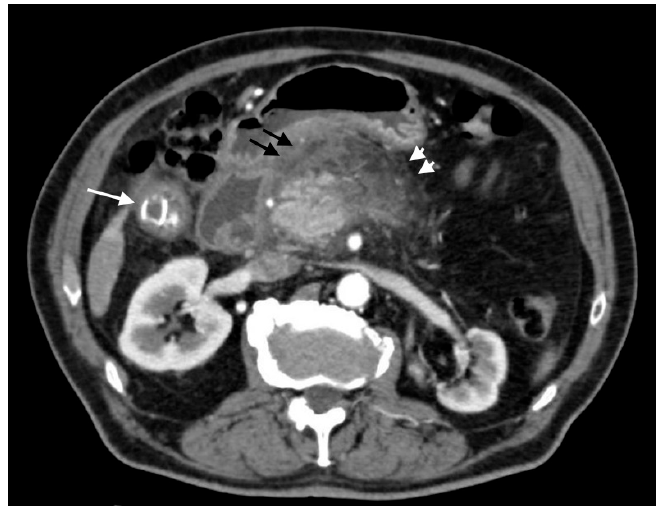
Figure 14. Acute calculous cholecystitis with pancreatitis (biliary pancreatitis): axial scan shows an acute cholecystitis (white arrow) with edematous hypoattenuating pancreatitis with surrounding peripancreatic fat strands (arrowheads) and fluid (black arrows).